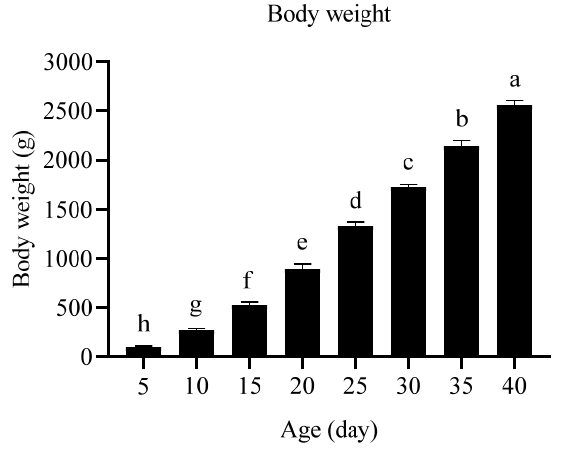
Figure 1. Effects of age on the body weight of broilers from 5 to 40 days. The values are the means of eight broilers (n = 8) and presented as mean±standard deviation. a-h Values with different superscripts are significantly different (p<0.05).